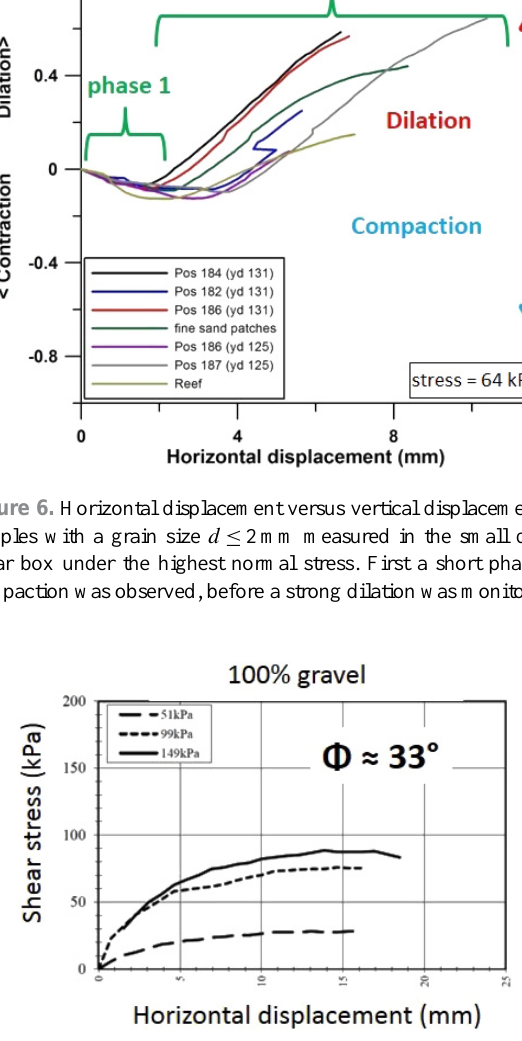
Figure 7. Horizontal displacement versus vertical displacement of gravel measured in the large direct shear